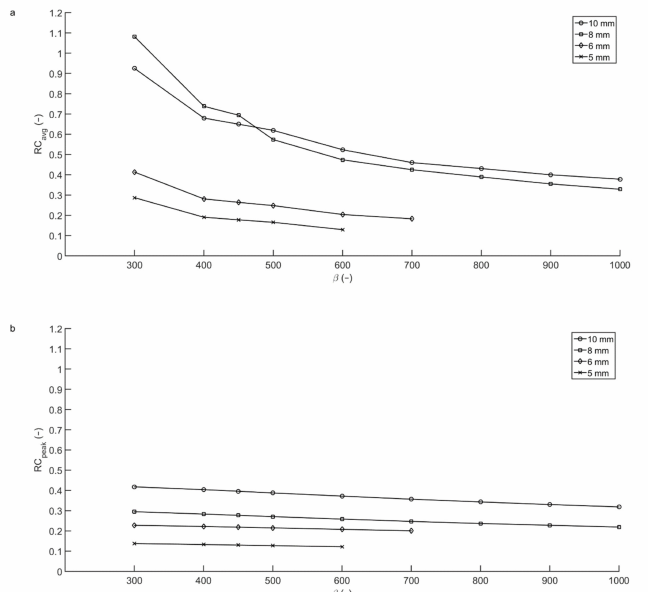
Figure 3. Average and peak recovery coefficients from the Micro Hollow Sphere phantom. For an acquisition time of two minutes per bed position, the apparent RC avg ( a ) of the 8 mm sphere measured with T/B ratio 10:1 exceeds that of the bigger spheres for low β , as the center of this sphere happened to coincide with the center of a voxel. Taking RC peak as a measure for the recovery coefficient ( b ), the recovery coefficients are lower, but more